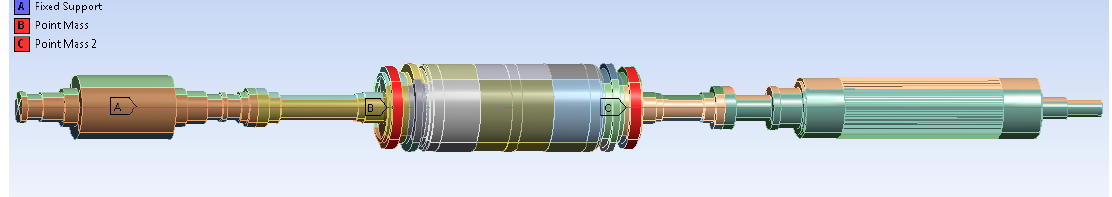
Figure 10. Applying boundary conditions and adding L-0 blades to the model.